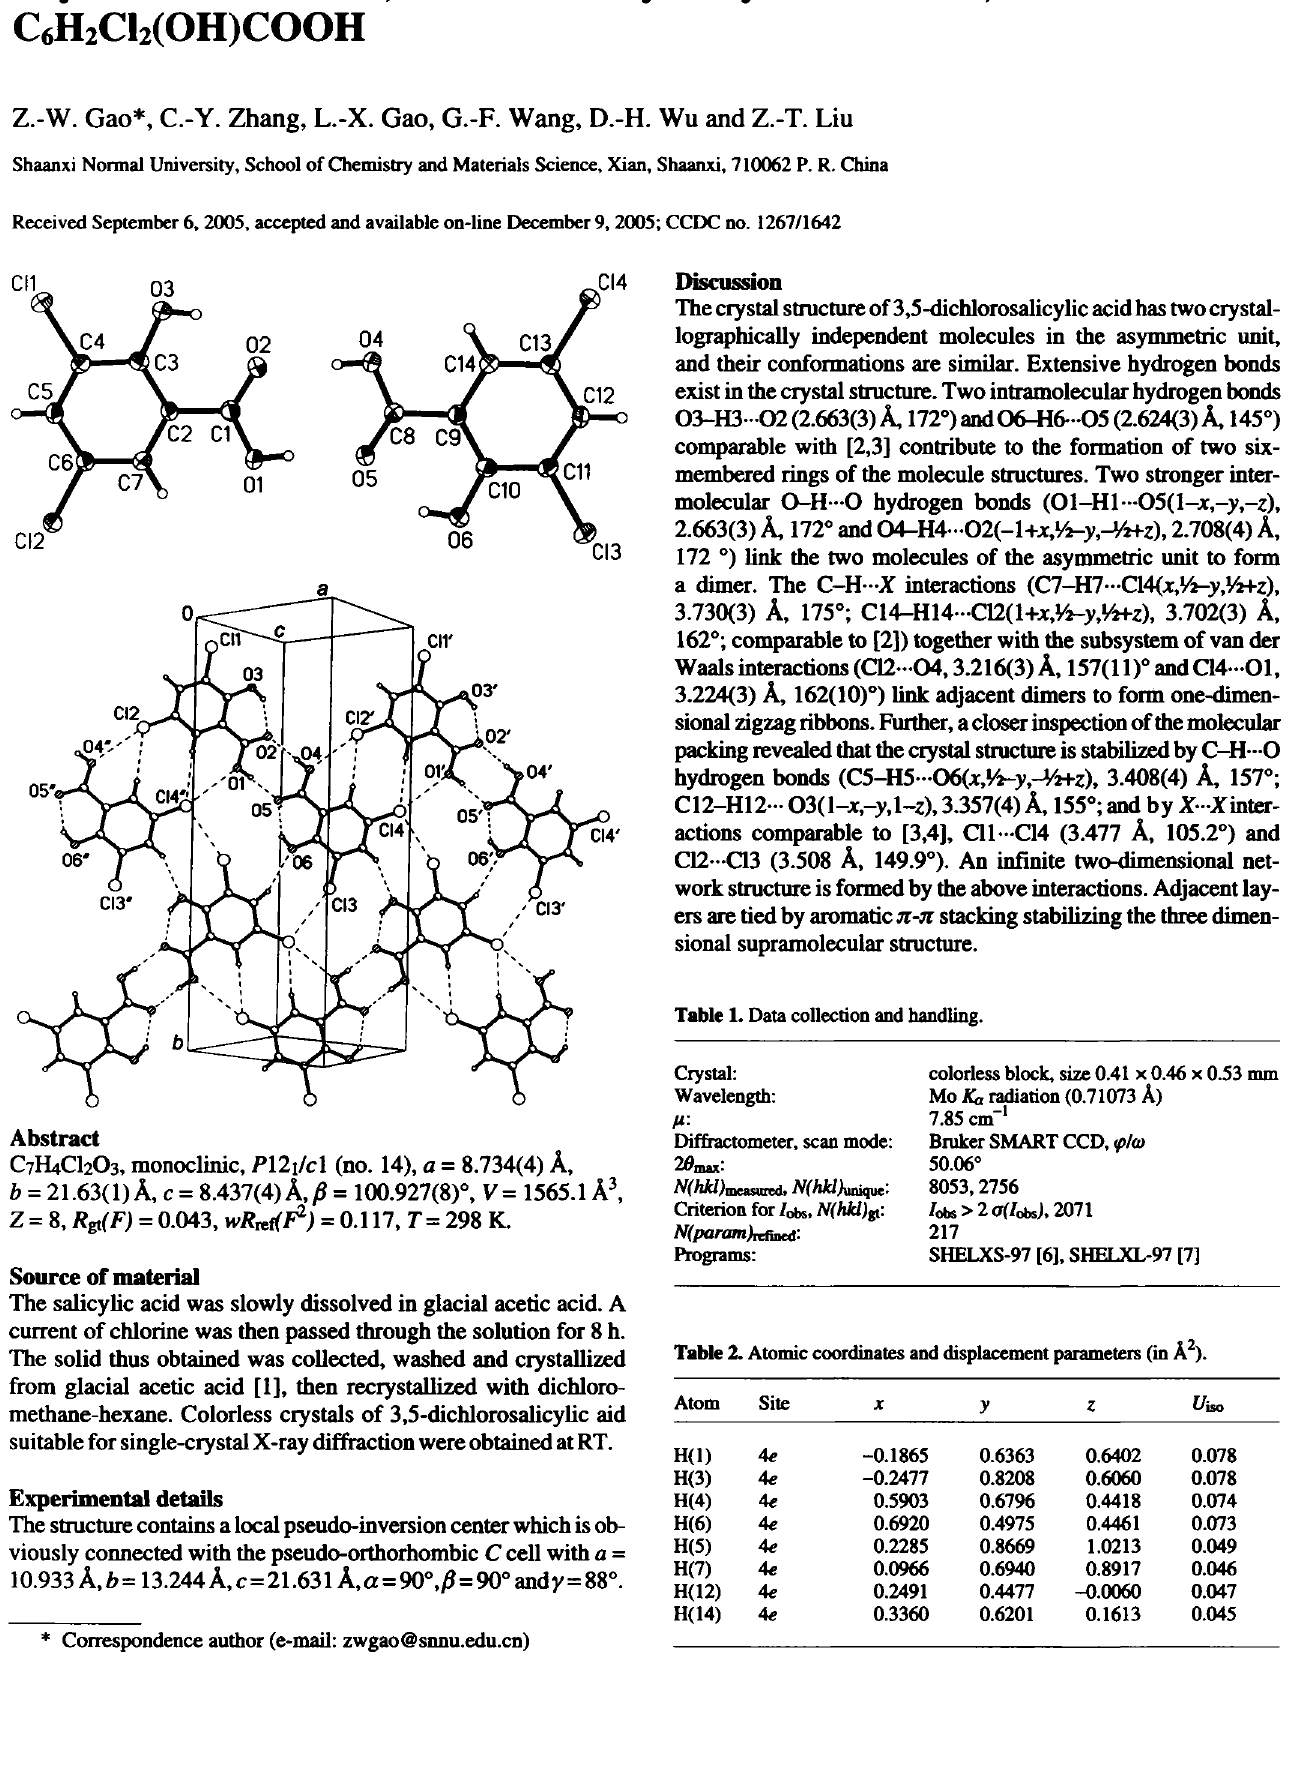
Table 2. Atomic coordinates and displacement parameters (in A 2